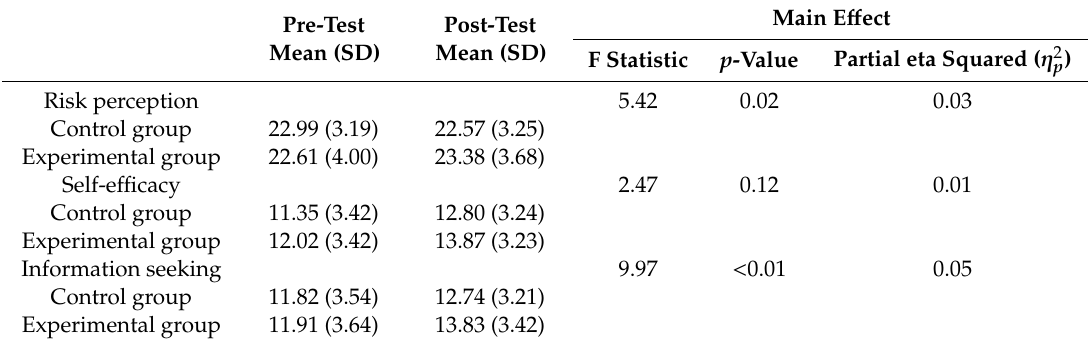
Table 3. Summary statistics for ANCOVA comparing post-test scores after controlling for covariates a